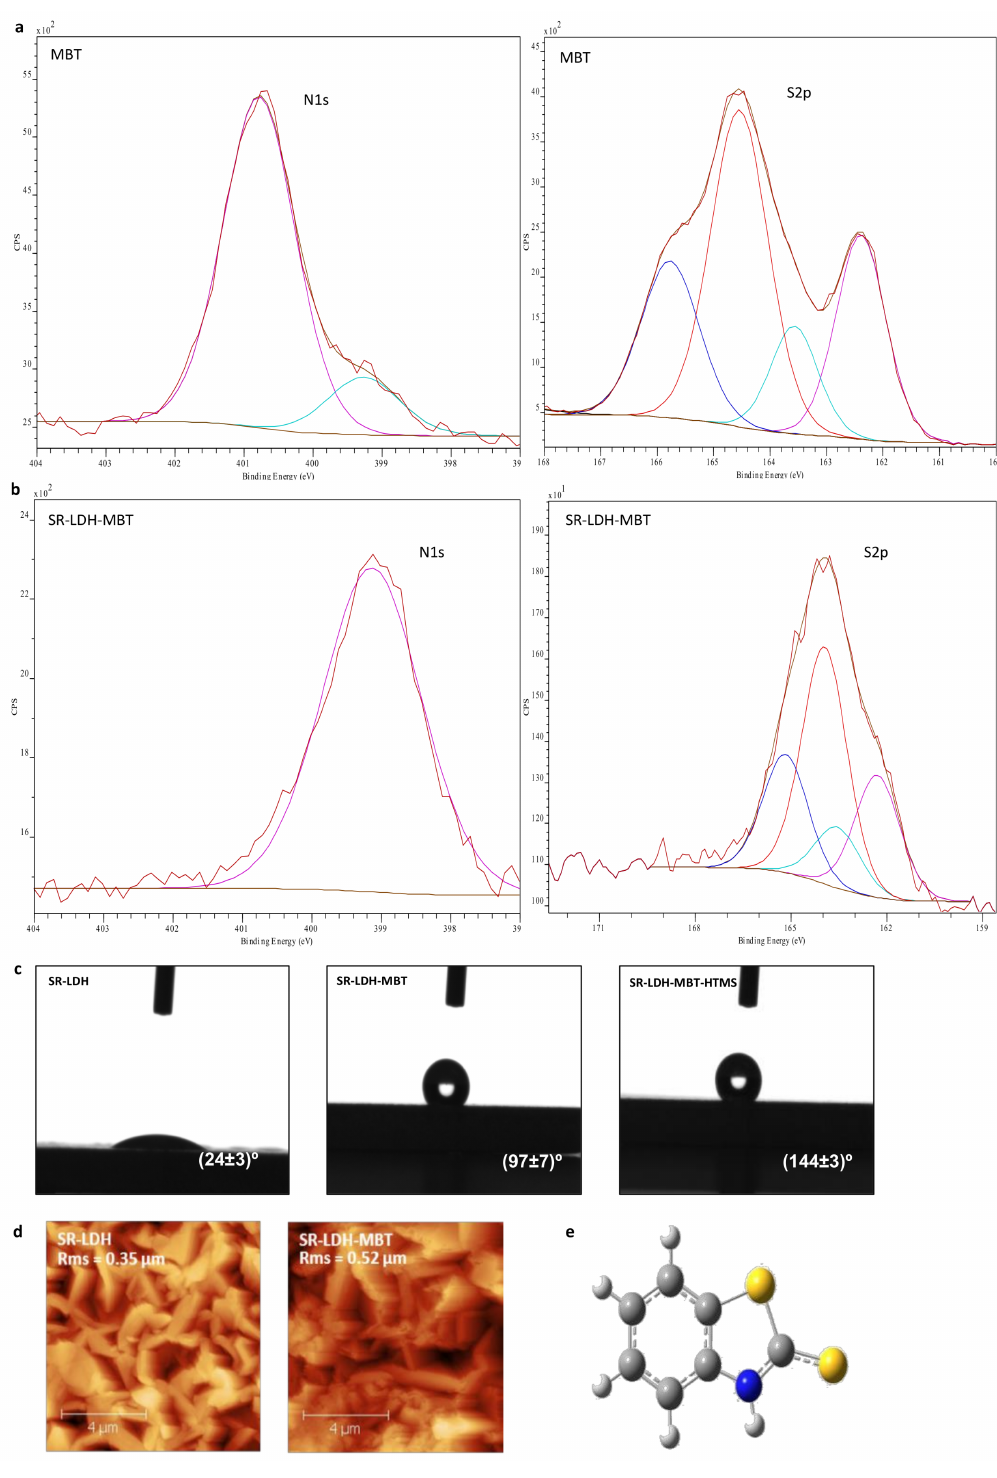
Figure 2. ( a ) and ( b ) X-ray photoelectron spectroscopy (XPS) spectra of MBT and SR-LDH-MBT; ( c ) contact angle measurements of SR-LDH films; ( d ) AFM topography images and roughness of SR-LDH and SR-LDH-MBT; ( e ) structure of